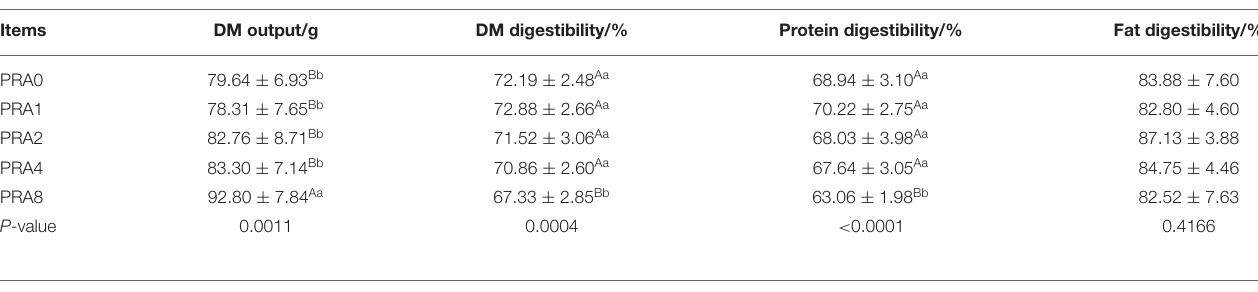
TABLE 3 | Effects of dietary PRA extract levels on nutrients digestibility of raccoon dog.